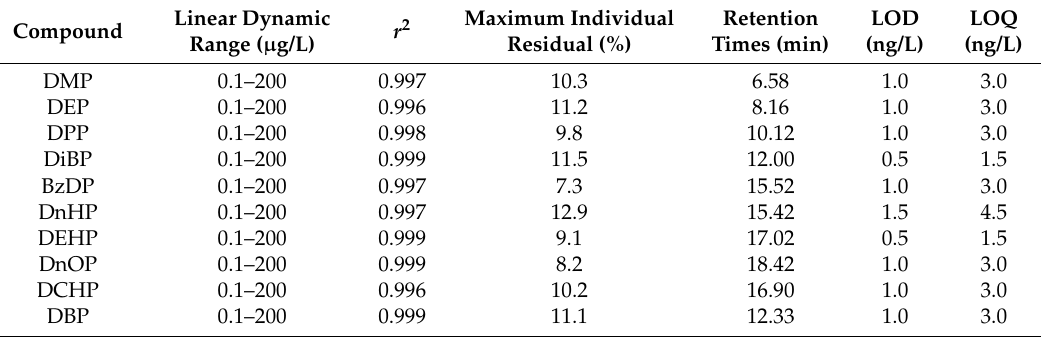
Table 4. Linear dynamic range ( µ g/L), determination coefficients ( r 2 ), residuals, retention times, limit of detection (LOD) and limit quantitation